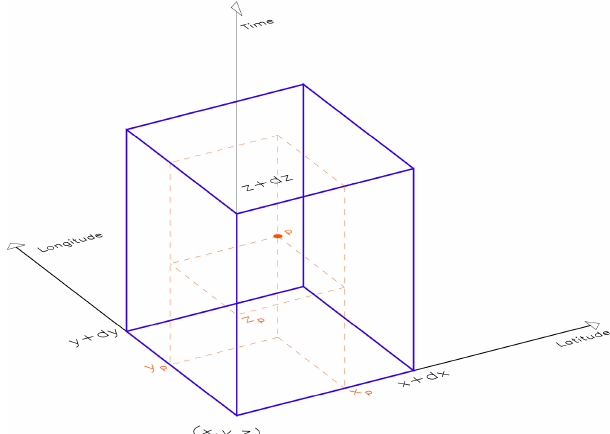
Figure 2. Illustration of an observation of coordinate ( x p , y p , z p ) in a cube for which vertices represent the model latitude ( x axis), longitude ( y axis), and forecast time ( z